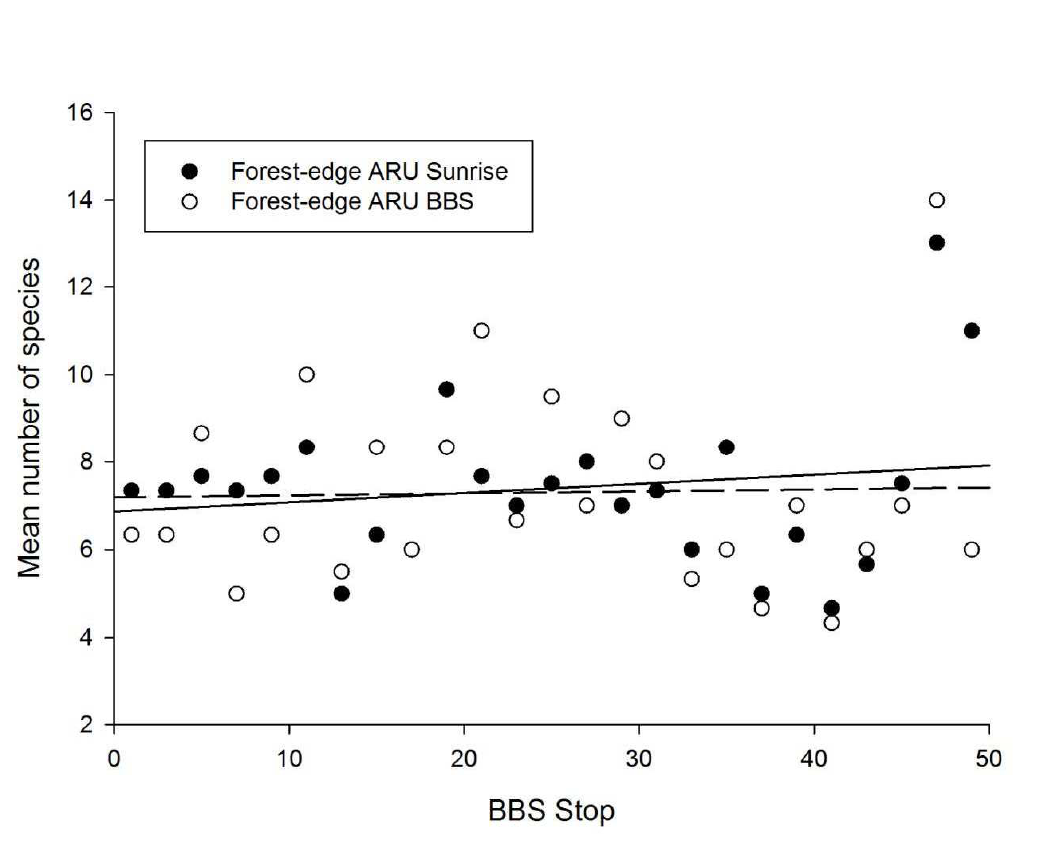
Figure A3.1. Mean number of species detected at each BBS stop from forest-edge ARU-based surveys conducted in 2015 during traditional BBS time and sunrise on three routes conducted in the Northwest Territories, Canada. Solid and broken lines indicate Forest-edge ARU Sunrise and Forest-edge ARU BBS,